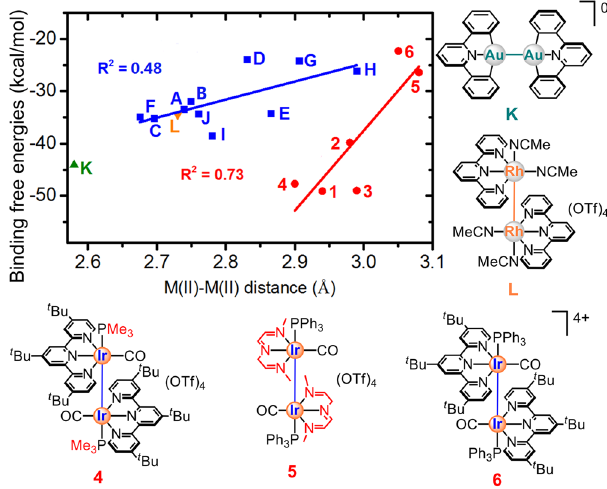
Fig. 4 Correlation of the computed M(II)-M(II) bond distances and binding free energies. The plot of metal(II) – metal(II) distances (Å) and their relative binding free energies (in kcal/mol) for some unsupported metal(II) – metal(II) complexes (M: Ir, Rh or Au) in acetonitrile by the SMD M06-L//M06-L method.